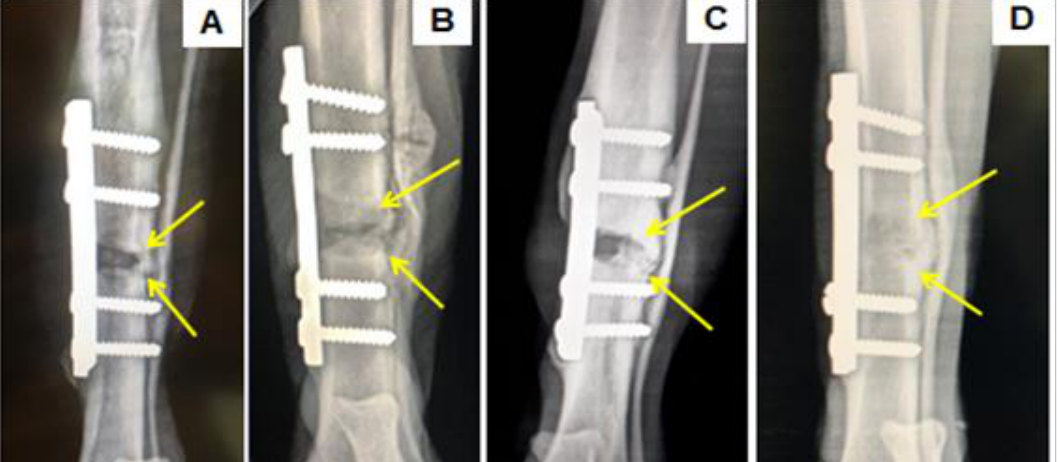
Figure 4. Radiological appearance (A) Control group at 4 th weeks post operation, slight periosteal reaction with low opacity at the edge of the defect (C) Control group at 12 th week post operation, rounded of bone defect sclerosis of the bone defect edge. (B) Treated group at 4th week post operation, more opacity observed at the site of bone defect with periosteal reaction at the edge of defect and deposition of osteiod bone (D) treated group at 12 th week post operation, the density of defect is similar of surroundings cortical part of bone with remodeling and the taken semi normal shape (arrow)